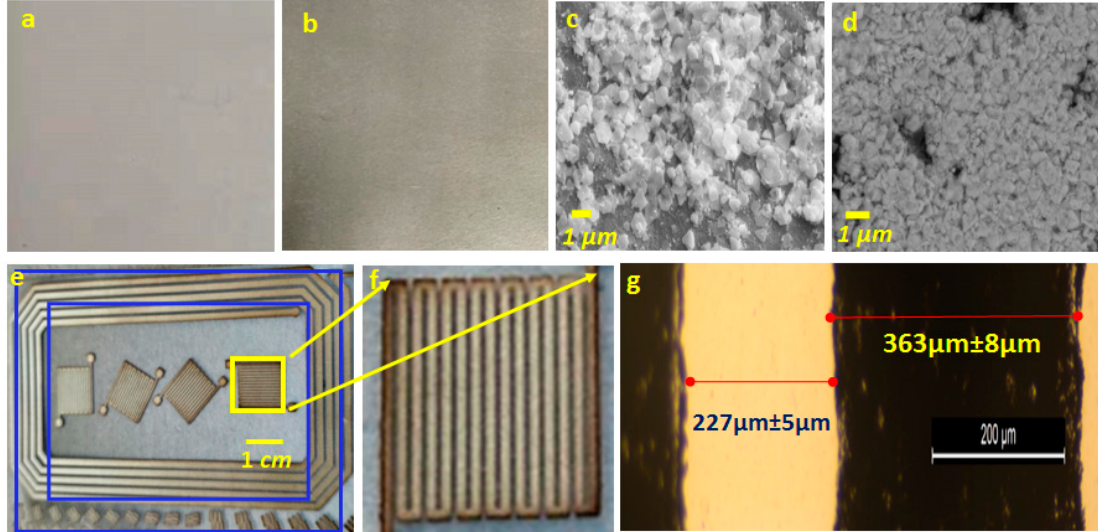
Figure 1. ( a ) Photo of printed silver on a Teslin paper substrate without rolling compression treatment; ( b ) photo of printed silver on a Teslin paper substrate with rolling treatment; ( c ) and ( d ) are SEM images (5000× magnification) of the small sample areas in (a) and (b). ( e ) Photo of printed silver interdigital pattern electrodes on thin polyethylene film where the blue frame outlines the resin-based sample holder and the gold frame area is magnified and shown in ( f ); ( g ) a randomly selected section of silver lines and polyethylene gap in (f) is further imaged by optical microscopy where the black area presents the silver lines and the yellow-orange area is the polyethylene gaps.